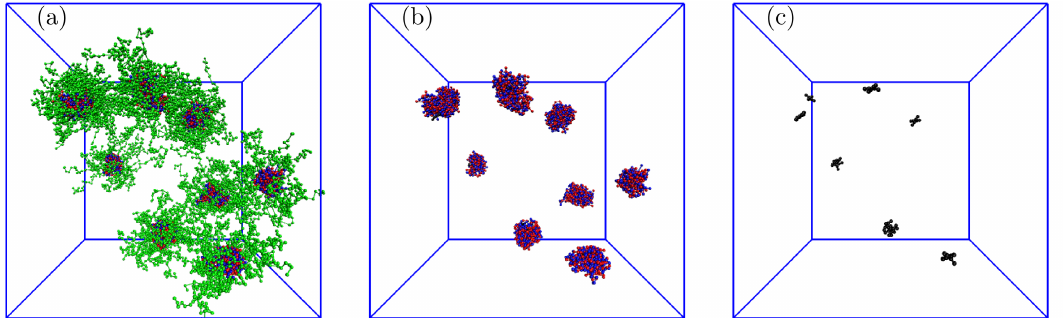
Figure 6. Typical snapshot of the simulation box for the system with 10 P + showing ( a ) whole associates, ( b ) IPEC cores with P + , and ( c ) P + only: the red and blue balls represent positively and negatively charged A blocks, respectively; the green balls are neutral B blocks, and the black balls are P +